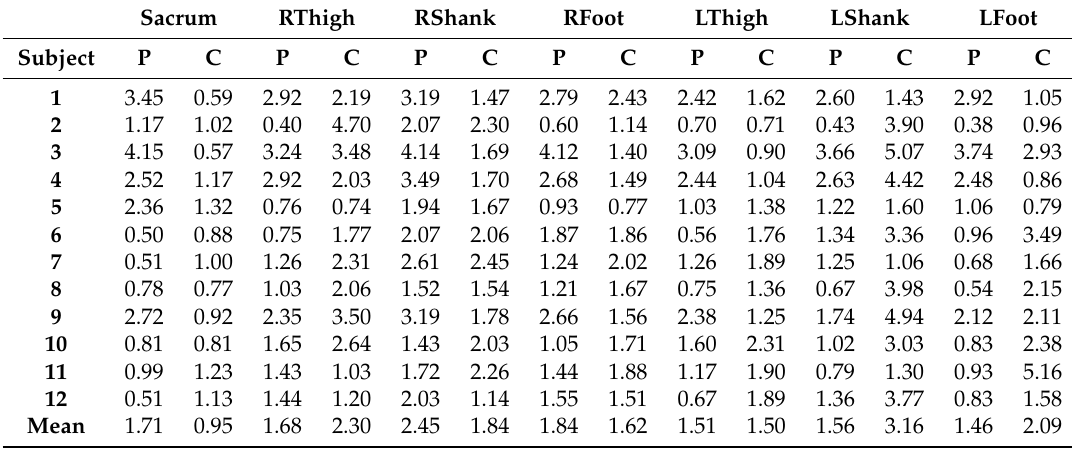
Table 4. Roll RMSE (degrees) by subject and IMU for the proposed (P) method and the control (C) method.